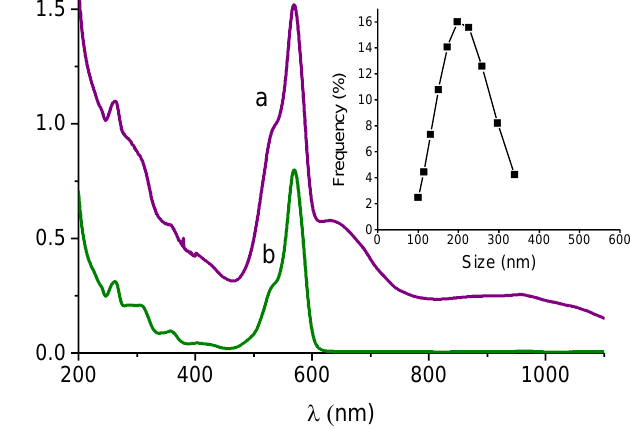
Figure 5. ( A ) Absorption spectrum of an aqueous dispersion of Au@PolyCD after stirring overnight with a thin film of RD-NO (a) and, for comparison, absorption spectrum of a solution of PolyCD (2 mg mL −1 ) encapsulating RD-NO (7 µM). The inset shows the size distribution of sample a measured by DLS.